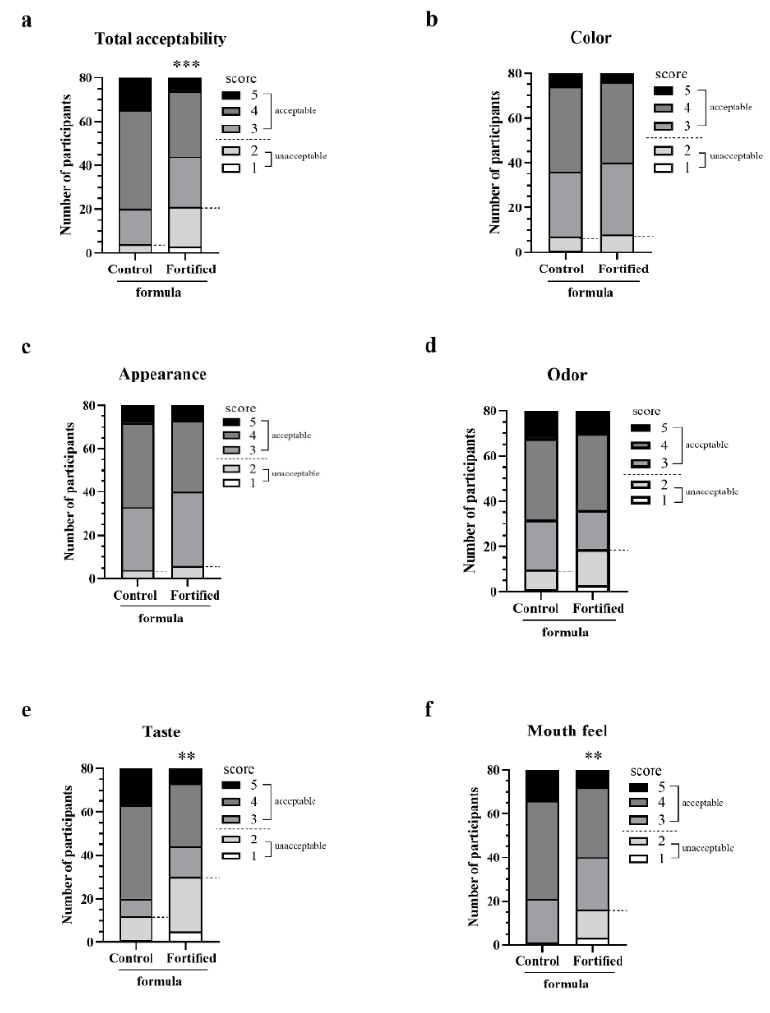
Figure 6. Results of sensory evaluation for control and fortified formulas of the rice-flavored control and fortified formulas. The stacked bars show the number of participants who assigned different scores on 5-point hedonic scales from 1 to 5 for total acceptability ( a ), color ( b ), appearance ( c ), odor ( d ), taste ( e ), and mouthfeel ( f ) of the control and fortified formulas with Japanese rice flavor. A score above 3 is acceptable. (***) and (**) mean p < 0.001 and < 0.01, respectively, obtained by chi-square tests.